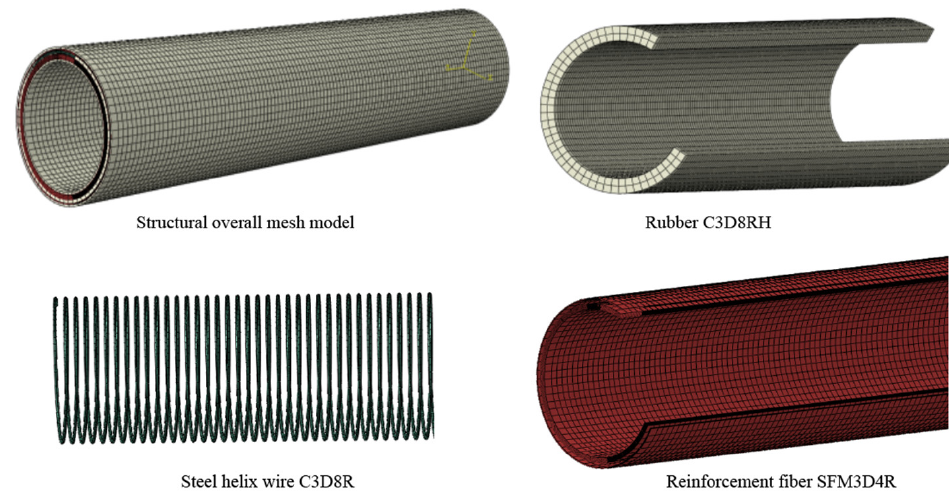
Figure 4. Mesh model of the submarine hose.